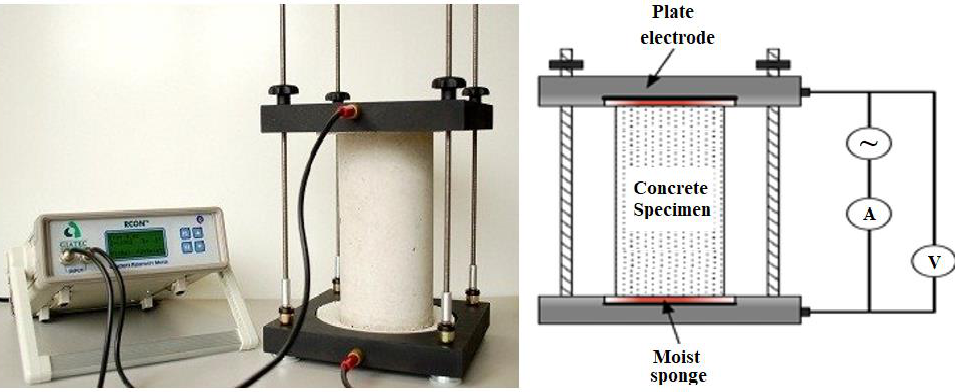
Figure 4. Test setup of the electric resistivity